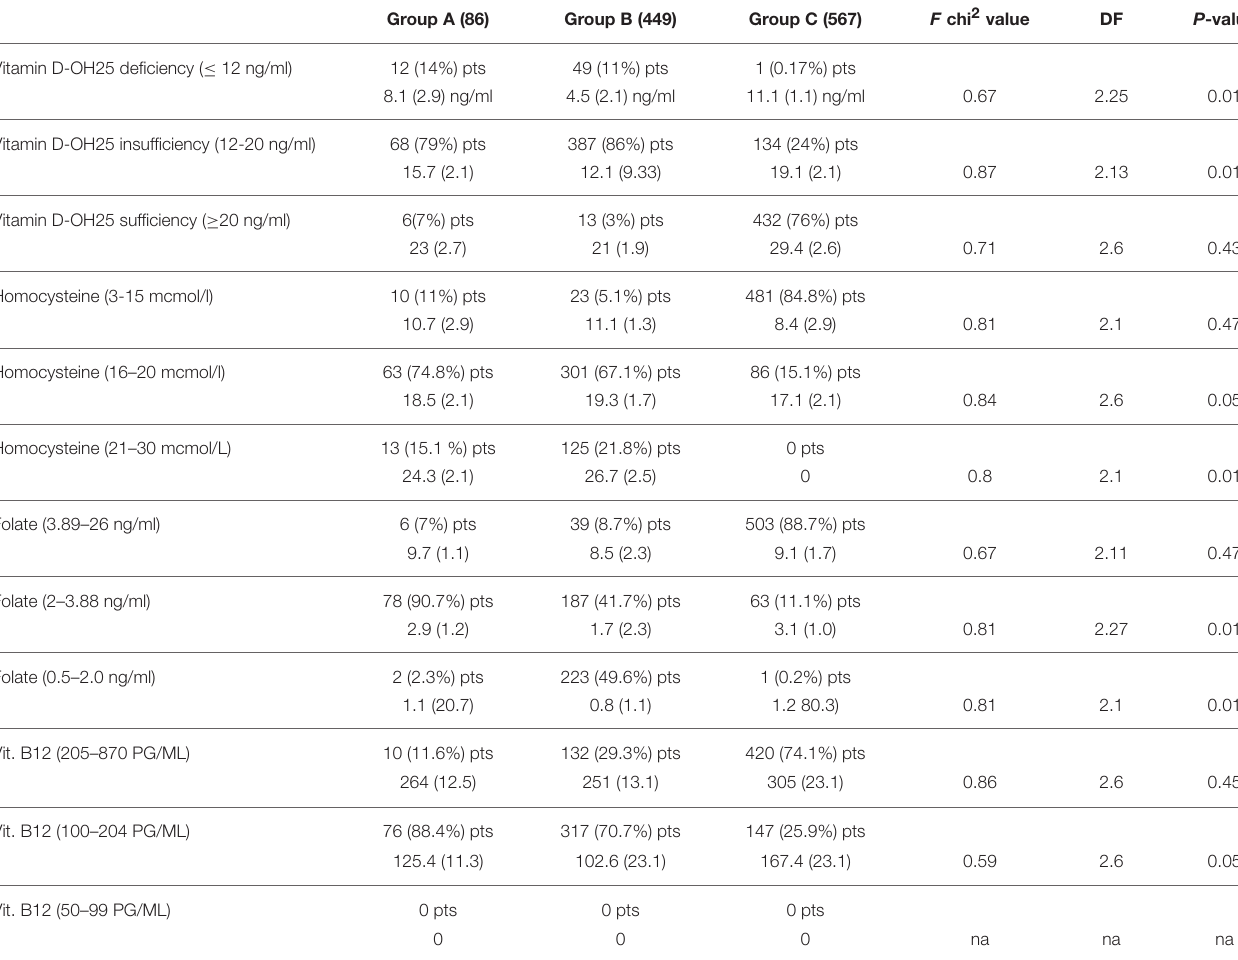
TABLE 3 | Comparison of mean value of vitamin D-OH, folate, vitamin B12, and homocysteine (divided by different levels) parameters in D, sVAD, and